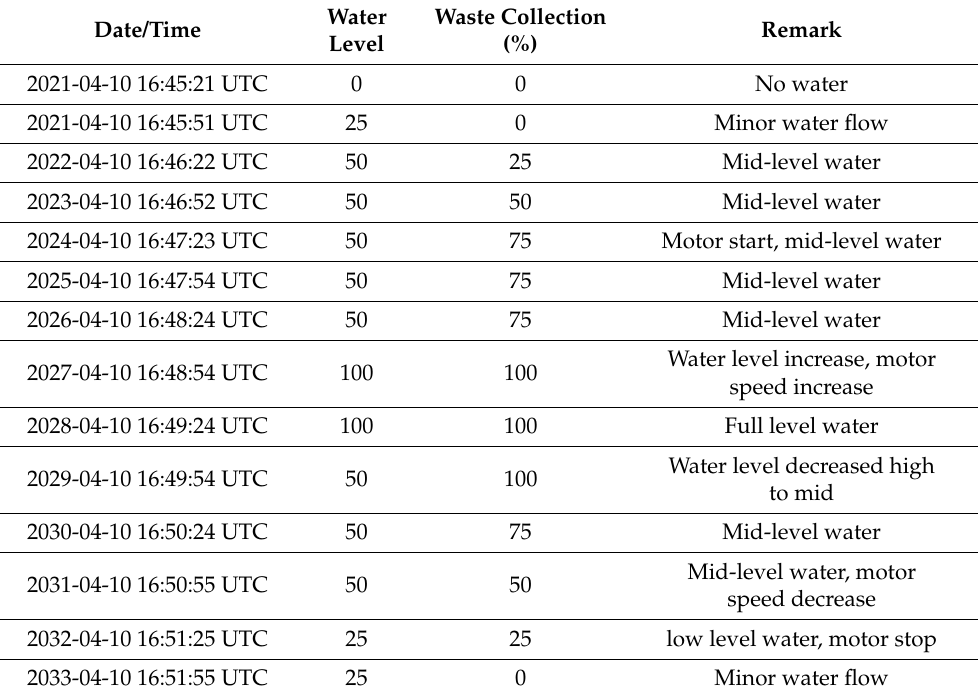
Table 1. Data collected from the cloud database.